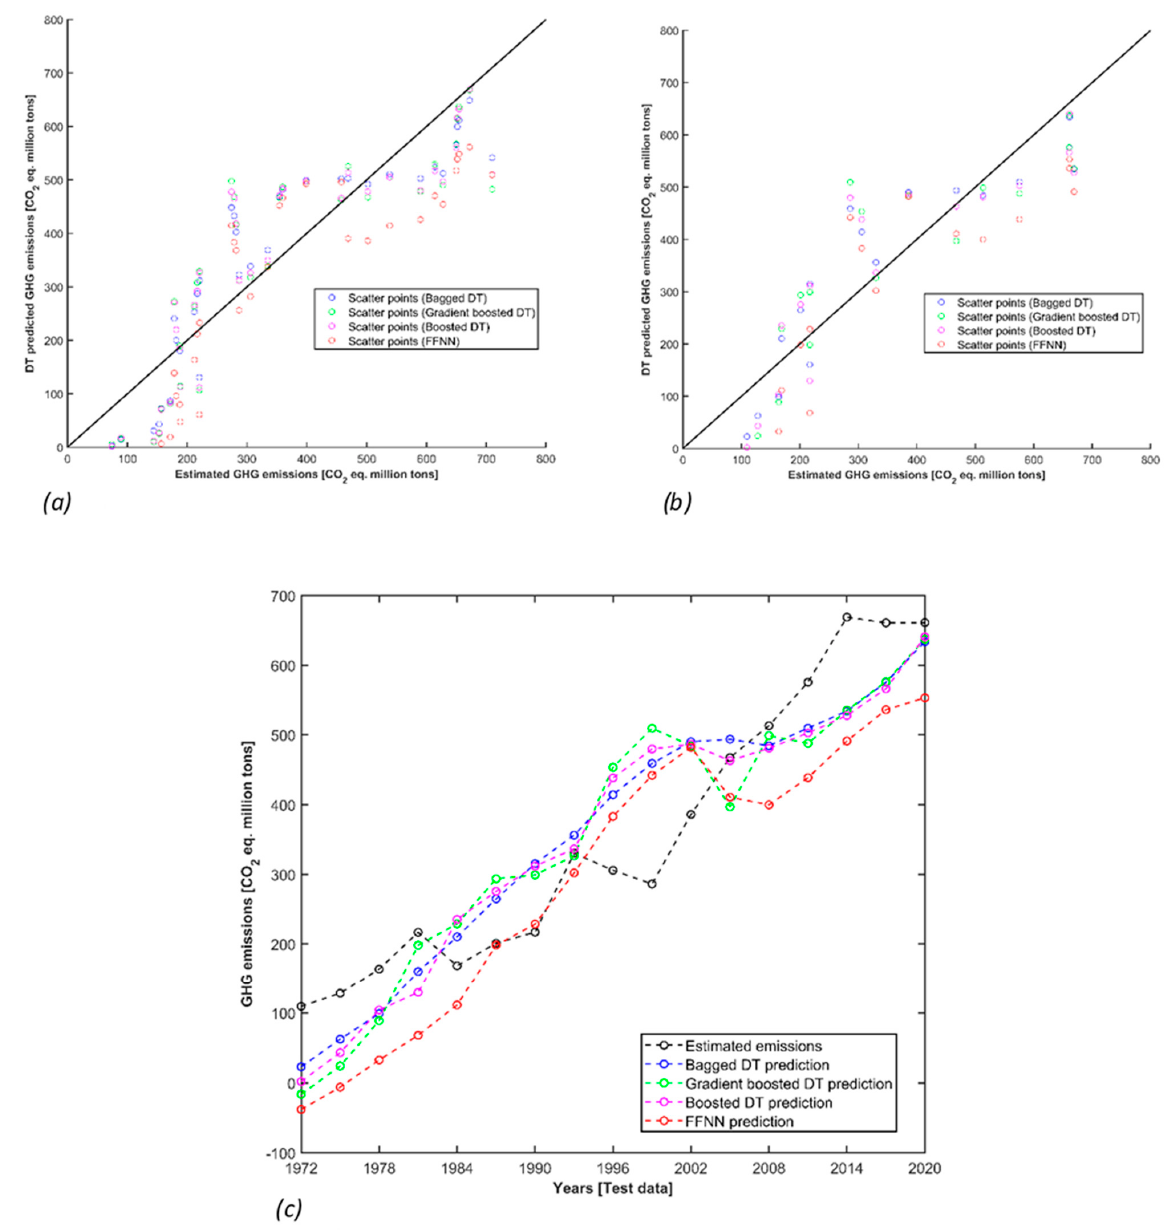
Figure 6. DT model output comparison: ( a ) Sca tt er plot for the training dataset; ( b ) sca tt er plot for